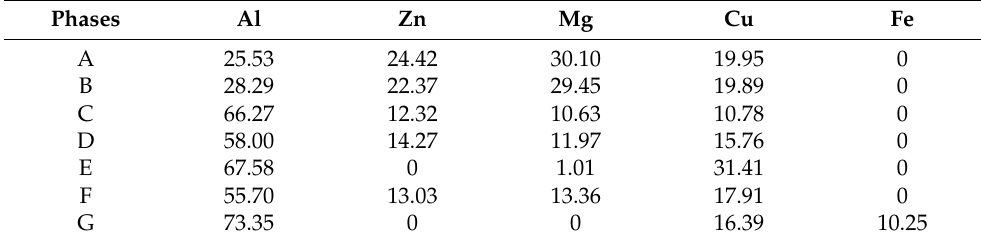
Figure 5. SEM (scanning electron microscope) images of squeeze casting process (SC) sample alloy with different magnifica- tions (wt.%): ( a , d ) Alloy A; ( e ) alloy C; ( b , c , f ) alloy D. Table 2. EDS analysis of constituent phases in Figure 3